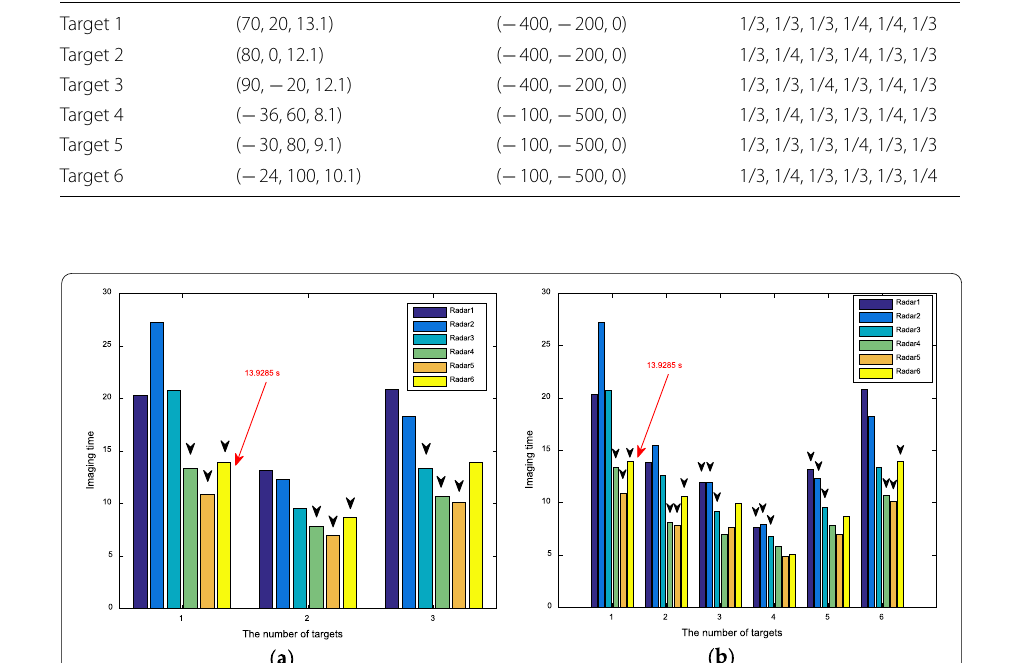
Fig. 10 Imaging time presented by histogram. a Scenario 1. b Scenario 2. The black arrows represent the selection of radars (i.e., radar selection strategy) and the red arrow indicates the total task time,